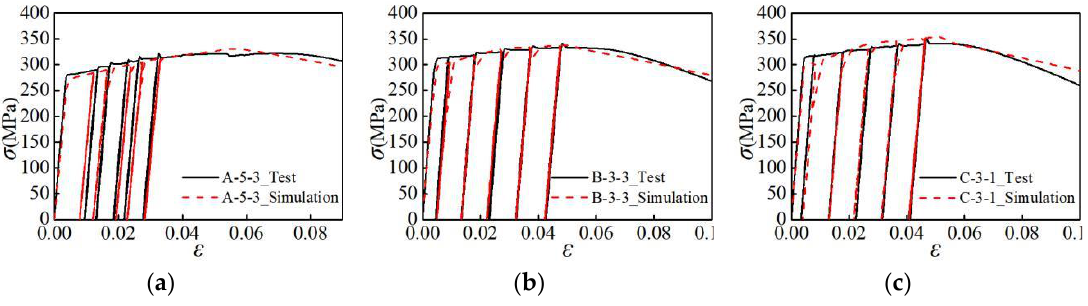
Figure 13. Stress-strain curves of specimens and simulation: ( a ) A-5-3 specimen; ( b ) B-3-3 specimen; ( c ) C-3-1 specimen.